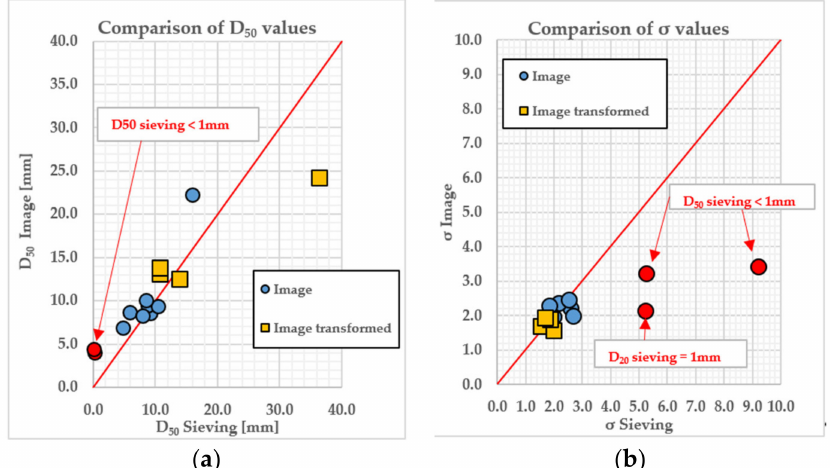
Figure 11. Comparison of the ( a ) D 50 and ( b ) standard deviation values from the best fitting (original image distribution or transformed distribution) methods and the sieving results. The sandy points are marked with red.